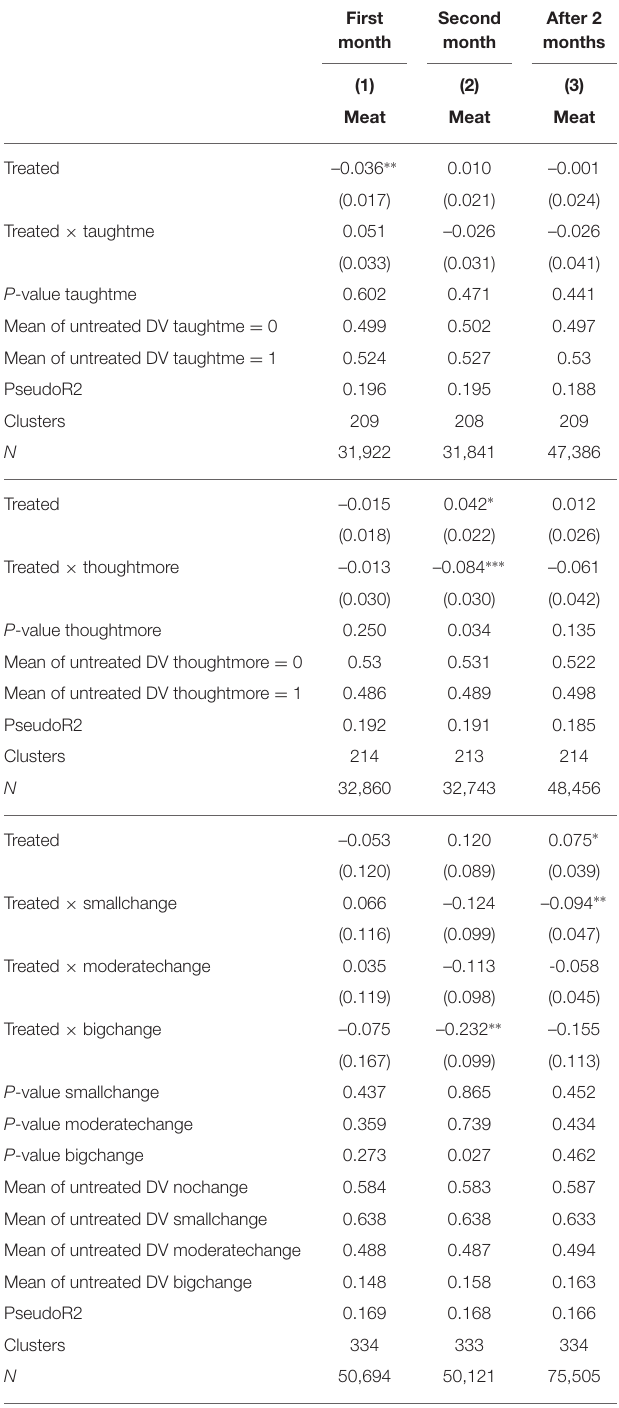
TABLE 5 | Heterogenous effects by survey measures: “taught me,” “thought more,” “willingness to make a